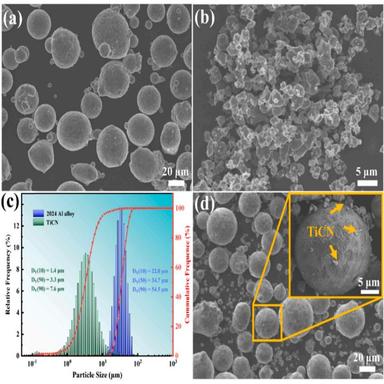
Powder morphology and particle size distribution, (a) 2024 Al alloy powder morphology, (b) TiCN powder morphology, (c) particle size distribution of 2024 Al alloy and TiCN powders, and (d) 2024-5 vol% TiCN composite powder morphology.